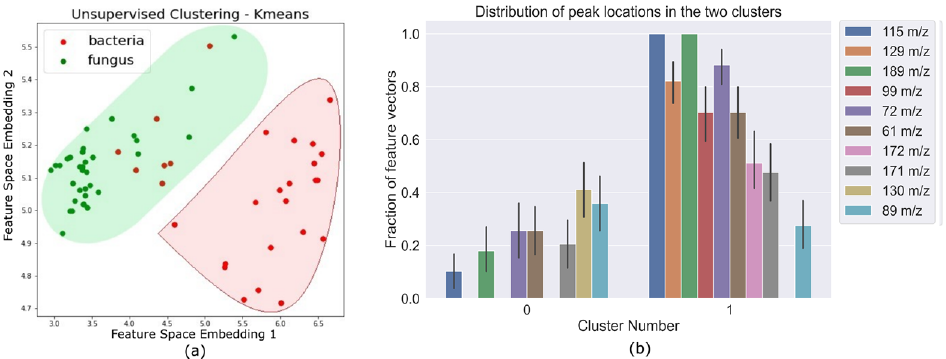
Figure 1. ( a ) Feature vectors corresponding to each pathogen as data points in the transformed feature space after k-means clustering for two clusters. The colored shaded regions cover all the points that were clustered together and the red and green differentiate between the two clusters. We can see that there is some inherent separability between bacteria (red data points) and fungi (green data points) in this transformed feature space. ( b ) This plot shows the variability of salient peak locations in each cluster. The clustering algorithm is able to automatically identify peak locations that are commonly seen in one pathogen type, and not seen in the